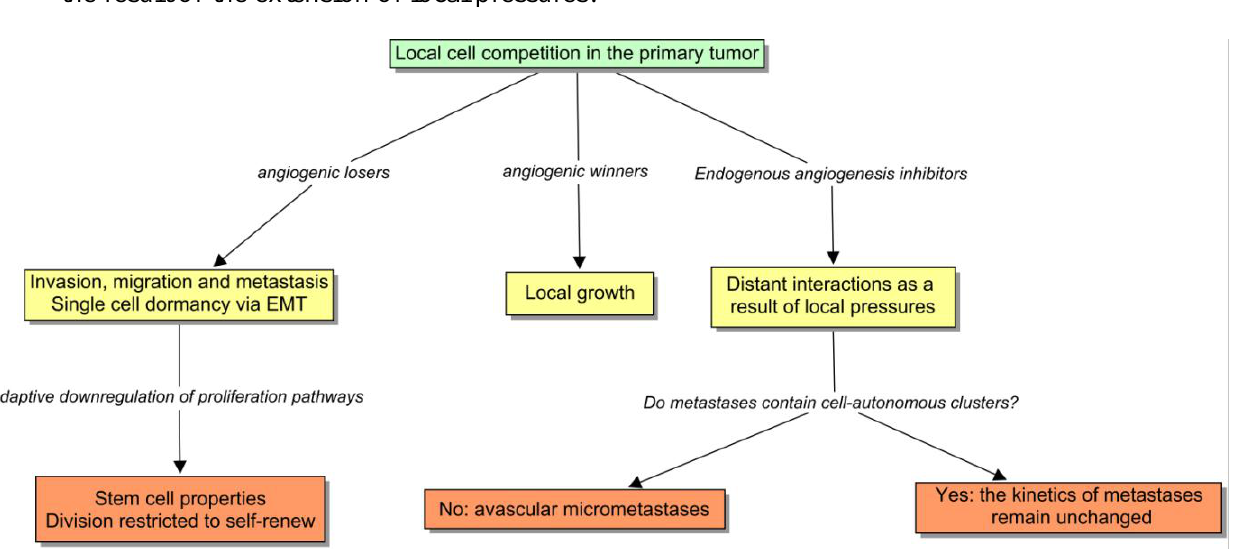
Figure 4. The competition between tumor subclones for the resources provided by neoangiogenesis, classifies cells in angiogenic winners and losers. Distant interactions are the result of the extension of local